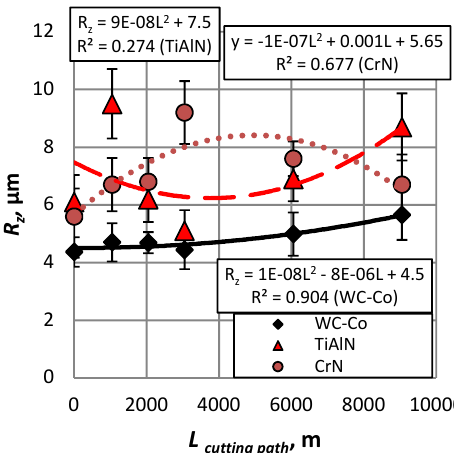
Figure 10. Influence of the cutting path L on the roughness of the surface R z (μm) processed with the tool from hard metal WC-Co (with and without PVD coatings) SEM images of the surface roughness of cutters of WC-Co with and without PVD coatings after the 9050 m path (or after 2.16 million work cycles) are presented in Figure 11.